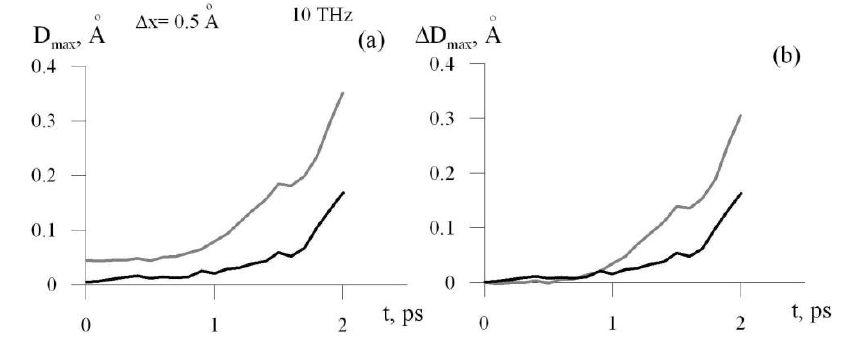
Fig. 26. Maximal dispersion versus time (а) and variations of the maximal dispersion in respect to the same value in the initial system before the external action start (b). Black line – perfect crystal, grey line – amorphized system.  x 0 = 0.5 Å,  =10